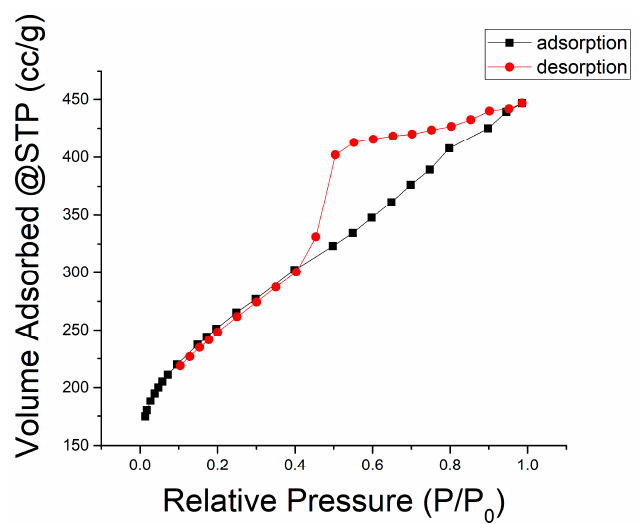
Figure 6. Nitrogen (77.35 K) physisorption isotherm (conditions: two-stage, 700 °C carbonization, 30 min activation).